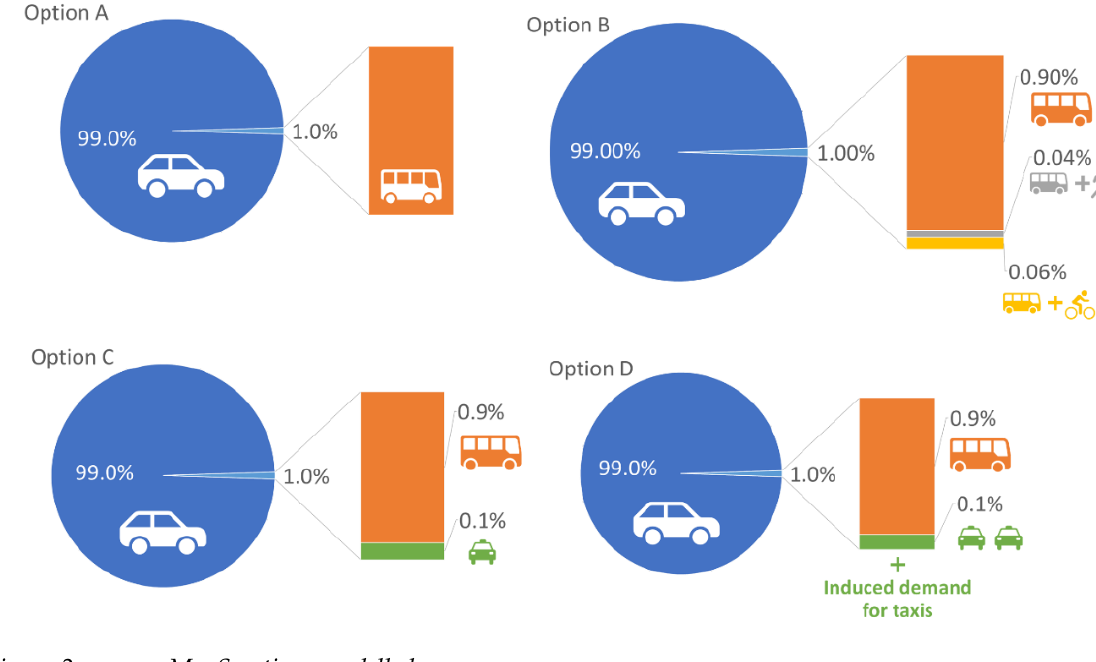
Figure 2. MaaS options